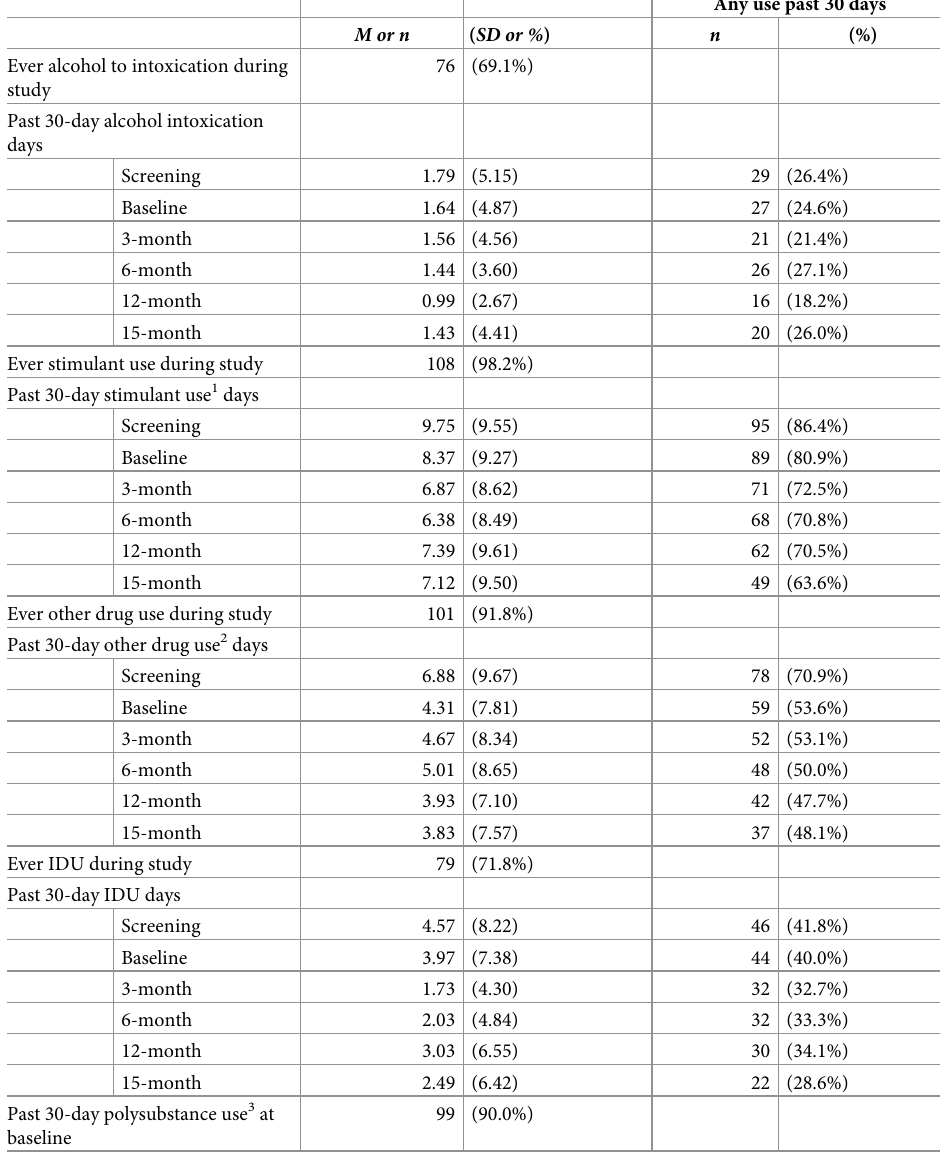
Table 2. Participant substance use characteristics N =